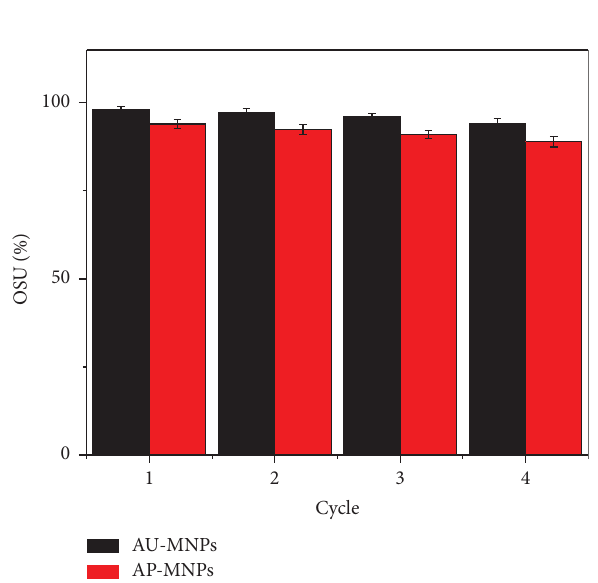
Figure 12: Reusability of AU-MNPs and AP-MNPs in four cycles at MNPs : oil ratio 1 :4 and contact time